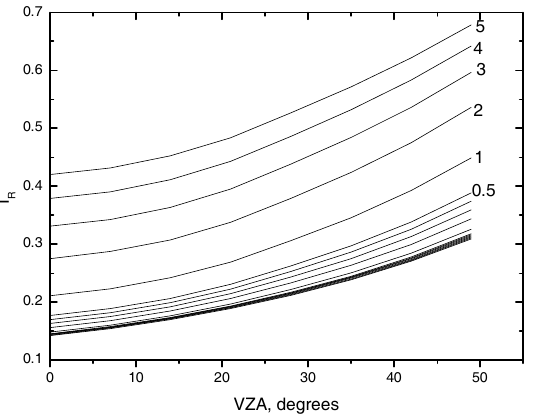
Fig. 7. The same as in Fig. 6 except for Q R .